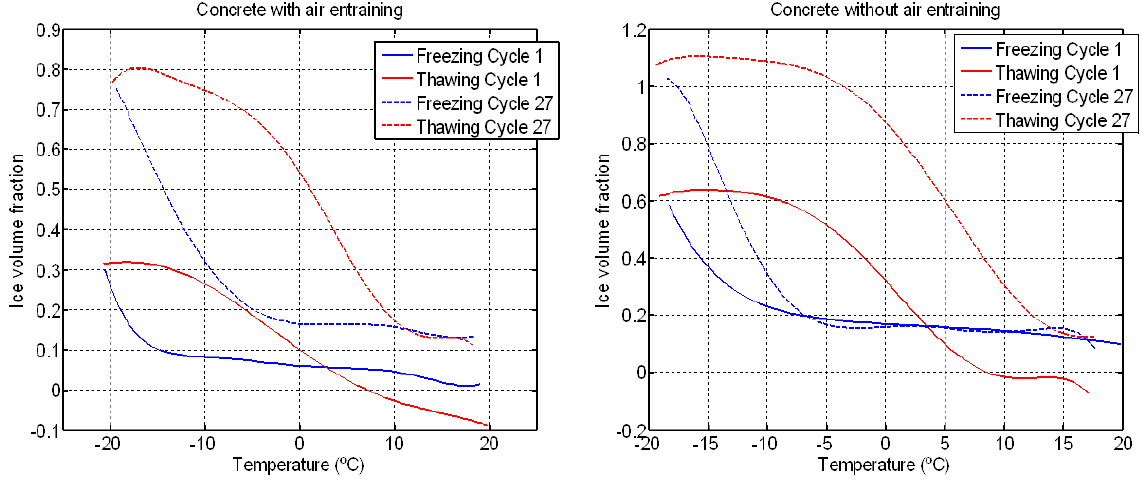
Figure 19. Variation of volume of ice during the F-T cycles from the micromechanical model and ultrasonic velocity.